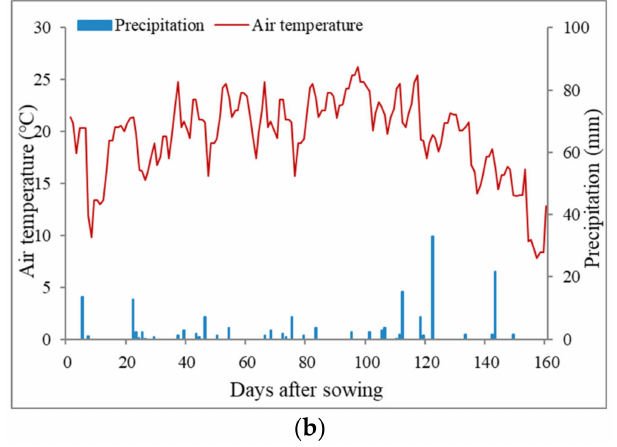
Figure 2. Daily average precipitation and temperature in Linze experimental station in 2019 ( a ) and 2020 ( b